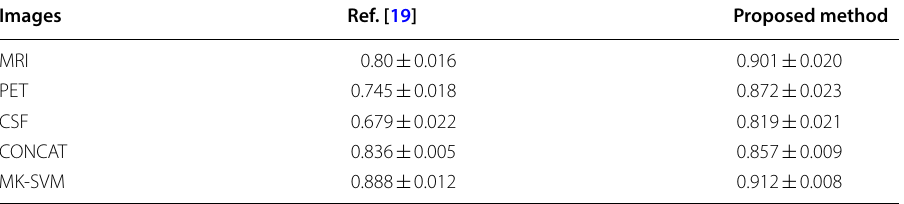
Table 5 The average accuracy of the methods in the MCI and HC classification Images Ref. [19]